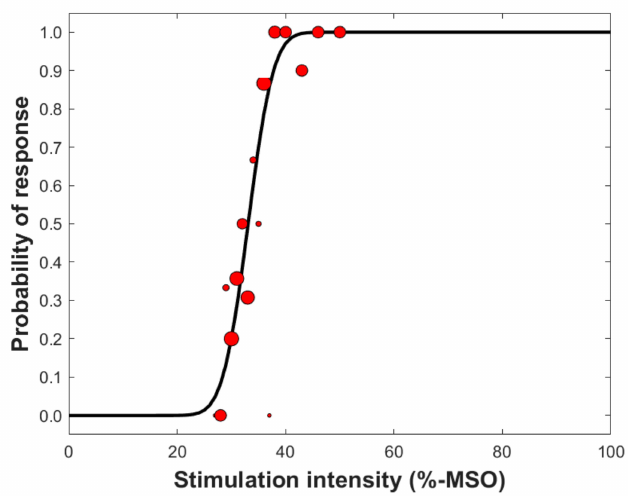
Figure 5. Example of the cumulative distribution function ( black line ) fitted to the experimental data of one subject. The red dots indicate the probability of response based on repeated MEP trials. The number of repetitions at each SI (given as %-MSO) is reflected in the marker size, which has been used to weight the fitting of the cumulative distribution